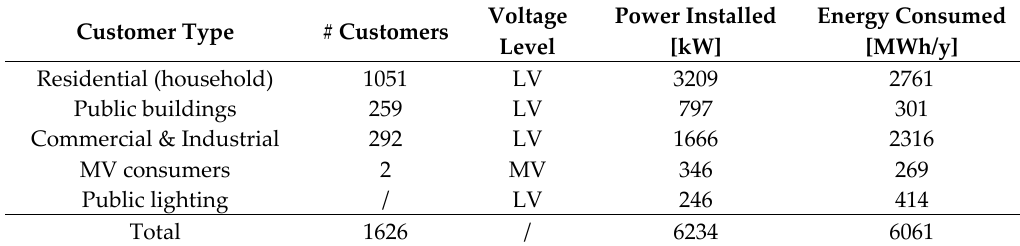
Table 1. Berchidda customers types and related energy purchase from the public